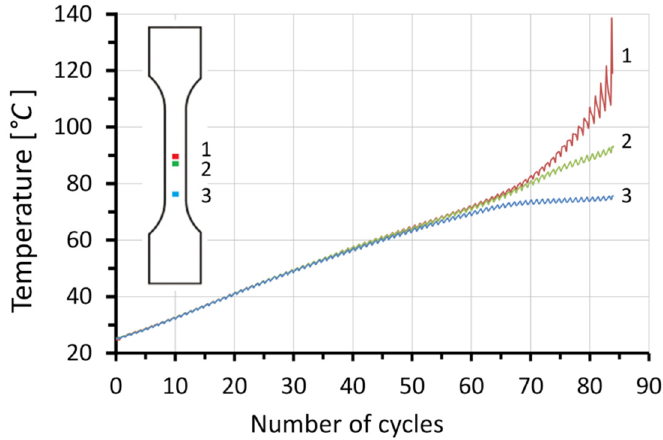
Figure 10. Temperature–number of cycles dependency in the selected sections.